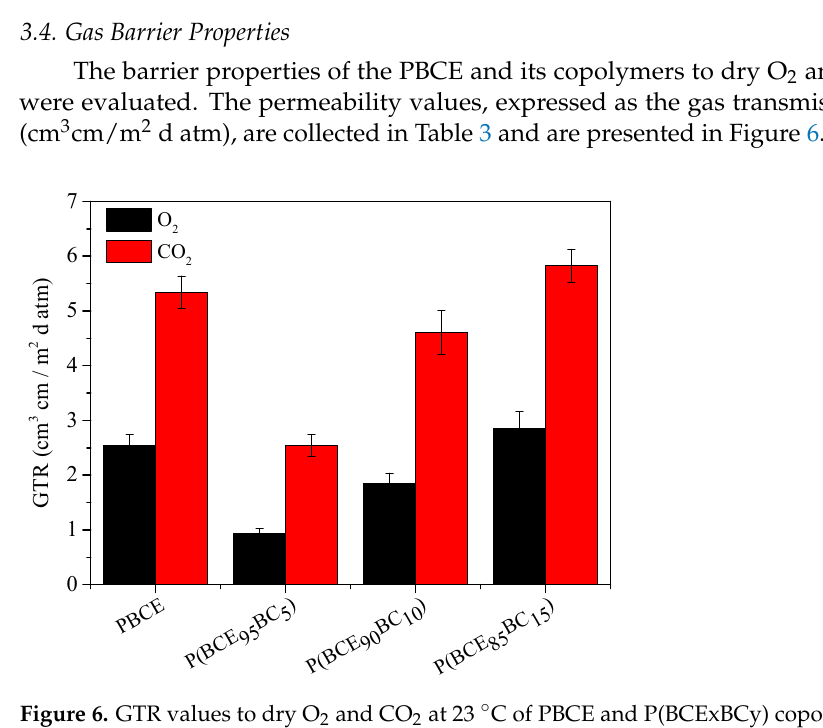
Figure 6. GTR values to dry O 2 and CO 2 at 23 °C of PBCE and P(BCExBCy) copolymers.